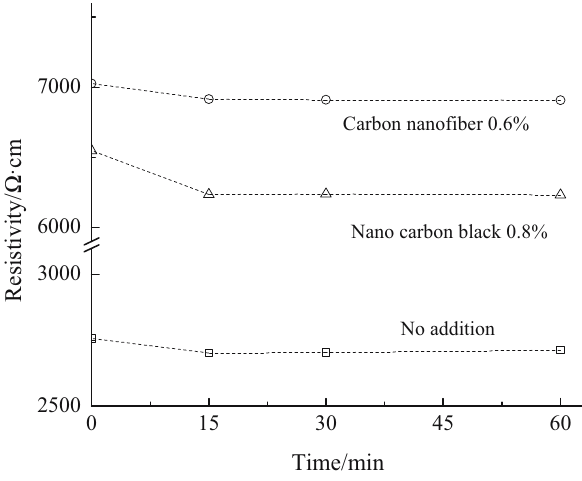
Figure 2: Relationship between conduction time and resistivity of